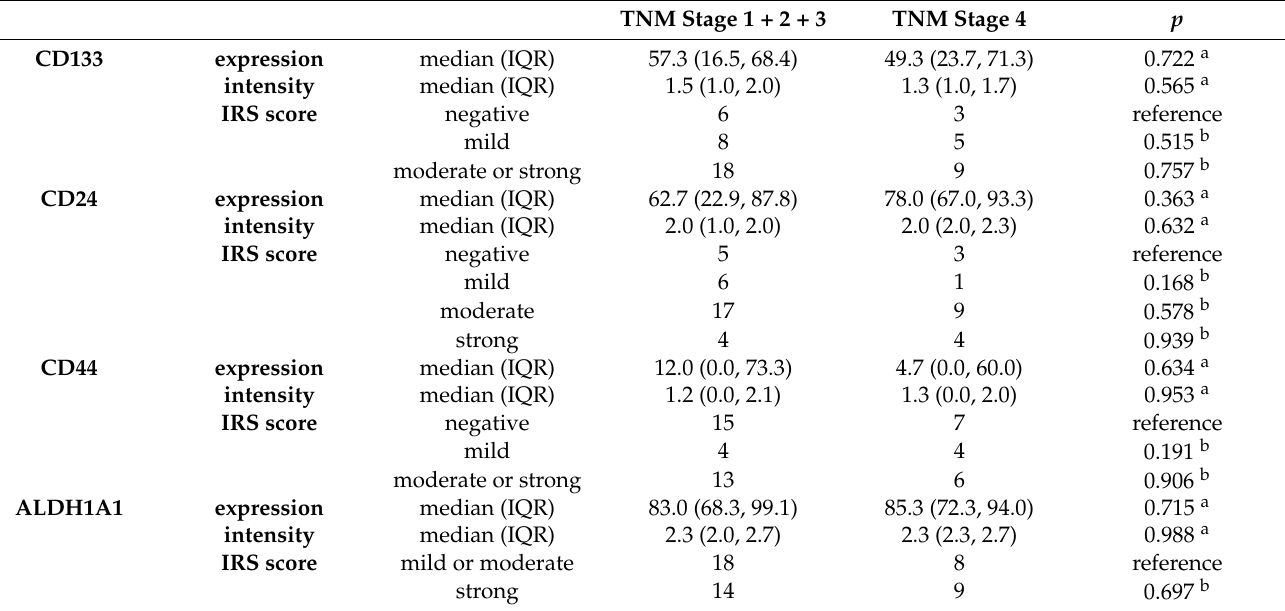
Table 3. Expression of the CSC markers in TNM stage 1 + 2 + 3 and TNM stage